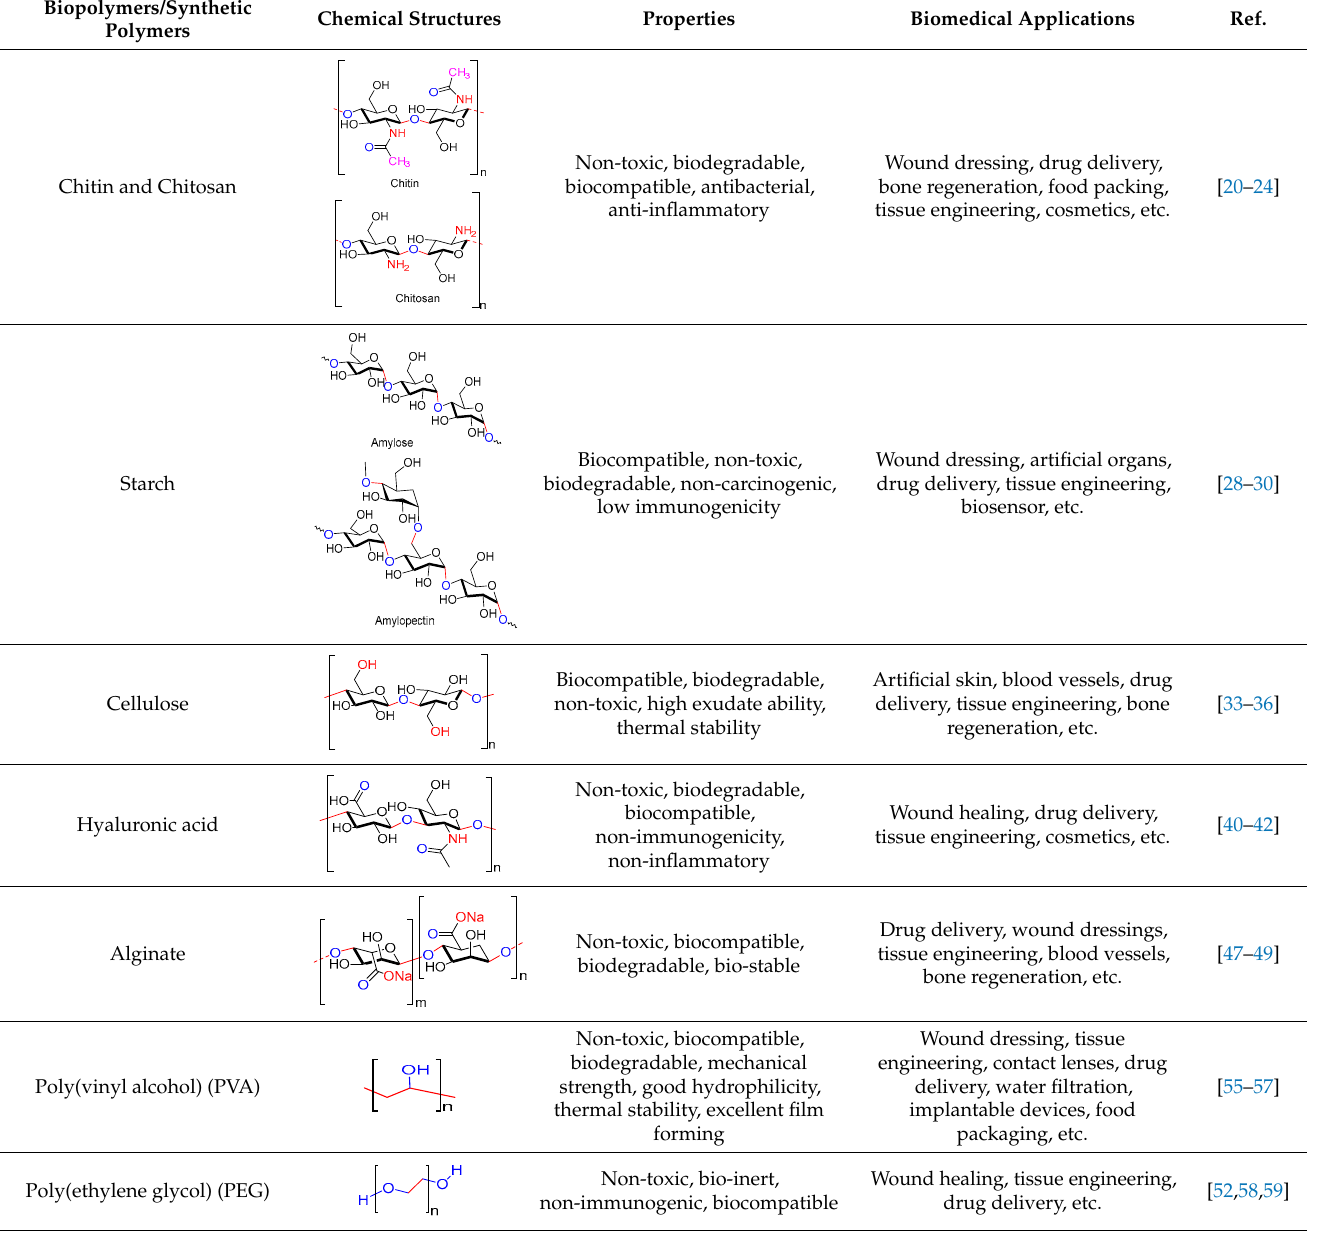
Table 1. Chemical structures, properties and biomedical application of the biopolymers and synthetic polymers. Biopolymers/Synthetic Polymers